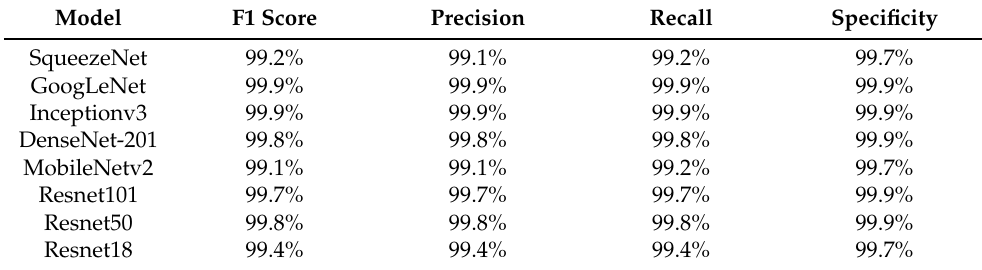
Table 2. Results for the performance evaluation metrics using 60% of the data for training. Numbers represent mean overall values over 10